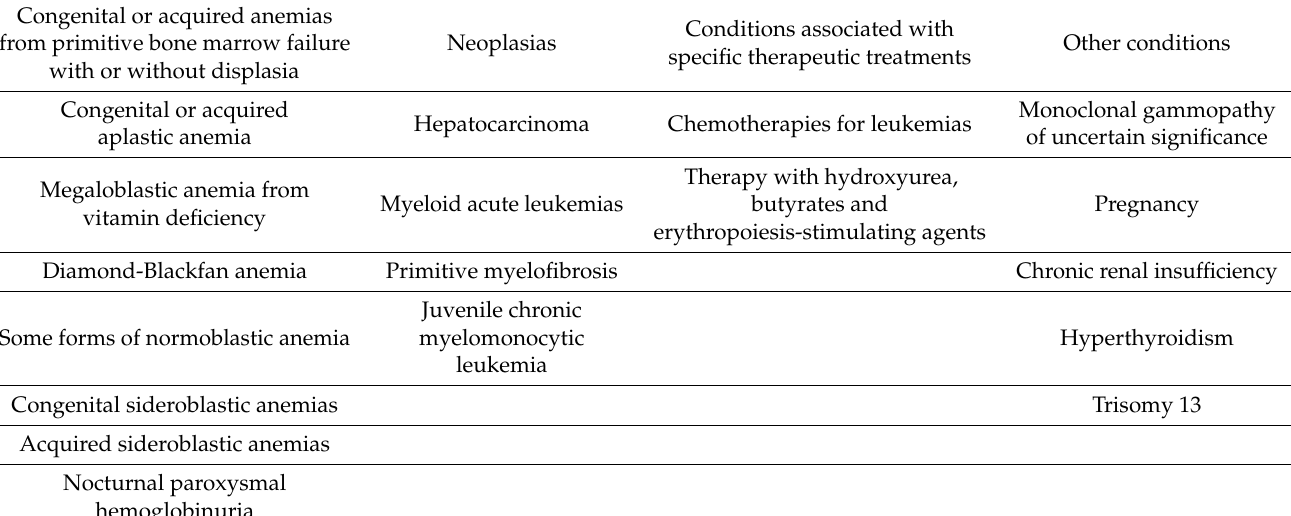
Table 7. Conditions in which an increase in HbF not ascribable to gamma globin defects can be detected.